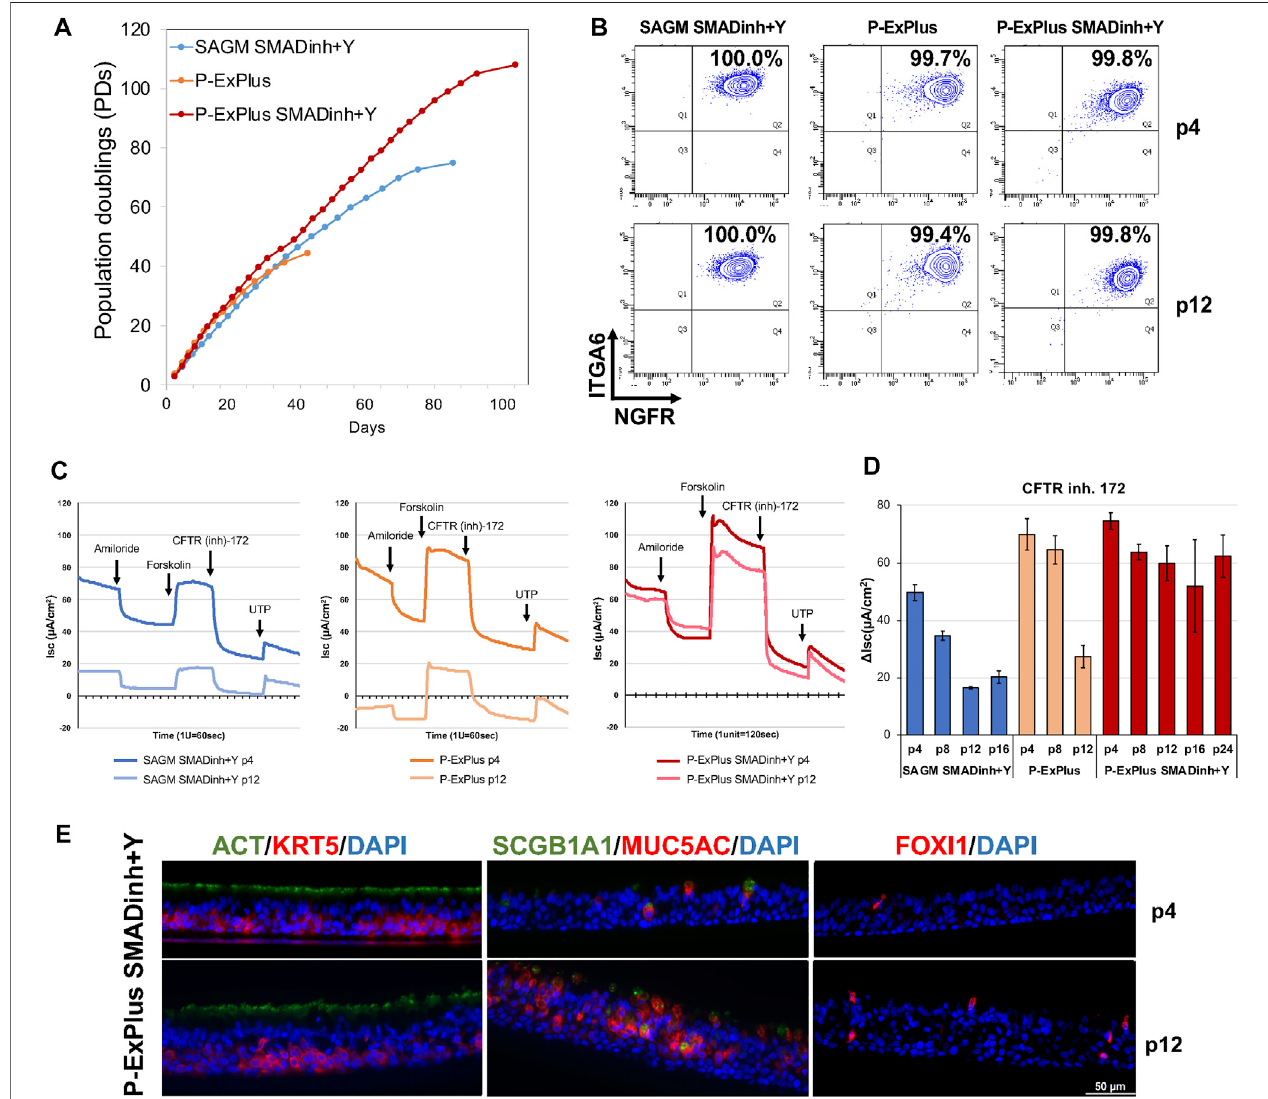
FIGURE 2 | Long-term expansion of BCs with retention of CFTR function. (A) Growth curve of BCs cultured in Small Airway Growth Medium with SMAD inhibitors andROCKinhibitor(SAGM/SMADinh+Y),andPneumacult-ExPluswithorwithoutSMADinhandY(P-ExPlus/SMADinh+YorP-ExPlus). (B) Flowcytometryanalysisof cells at passage 4(p4) andp12 in (A) .Cellsare immunolabeled forairway basalcellmarkers,ITGA6 and NGFR. (C) Individualelectrophysiological tracingsforALIs at p4 and p12 in the indicated media; times of acute treatments with amiloride, forskolin, and CFTR inhibitor-172 are indicated. (D) Ussing chamber analysis of ALIs derived from basal cells over the culture in (A) . The graph shows the current change in response to CFTR inhibitor-172. Shown are mean ± SD for 3-4 transwells per condition. (E) Transverse-section of ALIs derived from BCs expanded in P-ExPlus/SMADinh + Y at p4 and p12. Immuno fl uorescence staining for ionocytes (FOXI1), ciliated (ACT), secretory (SCGB1A1, MUC5AC) and basal (KRT5) cells. Scale bar = 50 μ m.